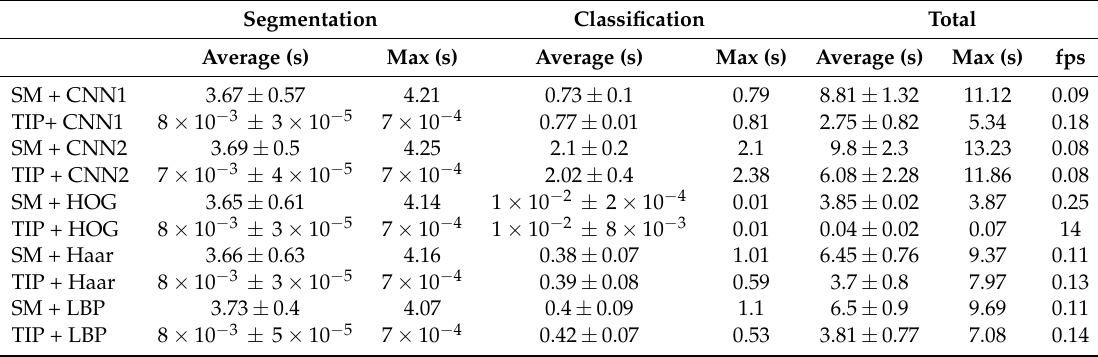
Table 7. Time estimation of PRS implementation in the Raspberry Pi 2 platform.